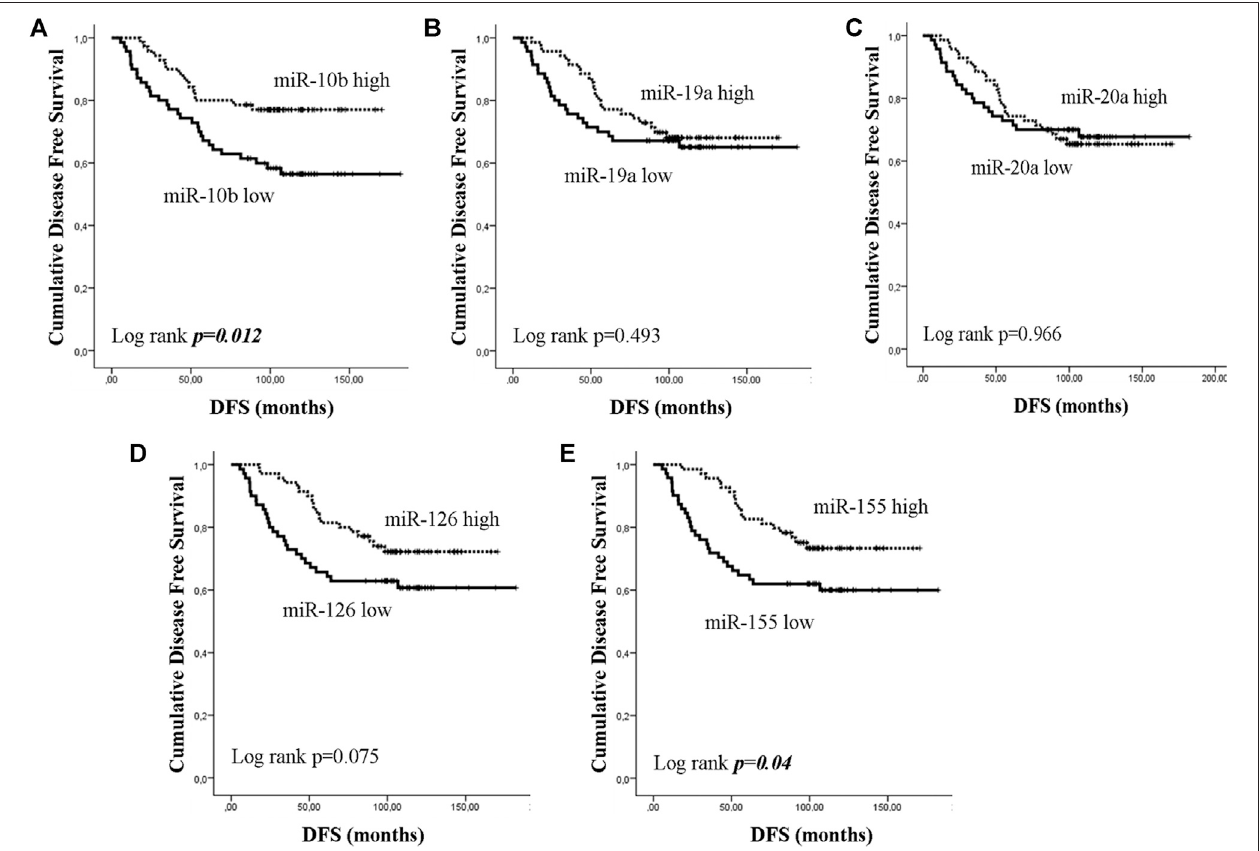
FIGURE 3 | Kaplan – Meier analysis for disease free survival (DFS) according to the expression of circulating miRNAs. Patients were classi fi ed as high or low expressiongroupsbasedonthemedianvalueofeachmiRNAexpression.DFSinpatientswithhighorlow (A) miR-10b, (B) miR-19a, (C) miR-20a, (D) miR-126,and (E) miR-155. Curves were compared using the log rank test. P values are